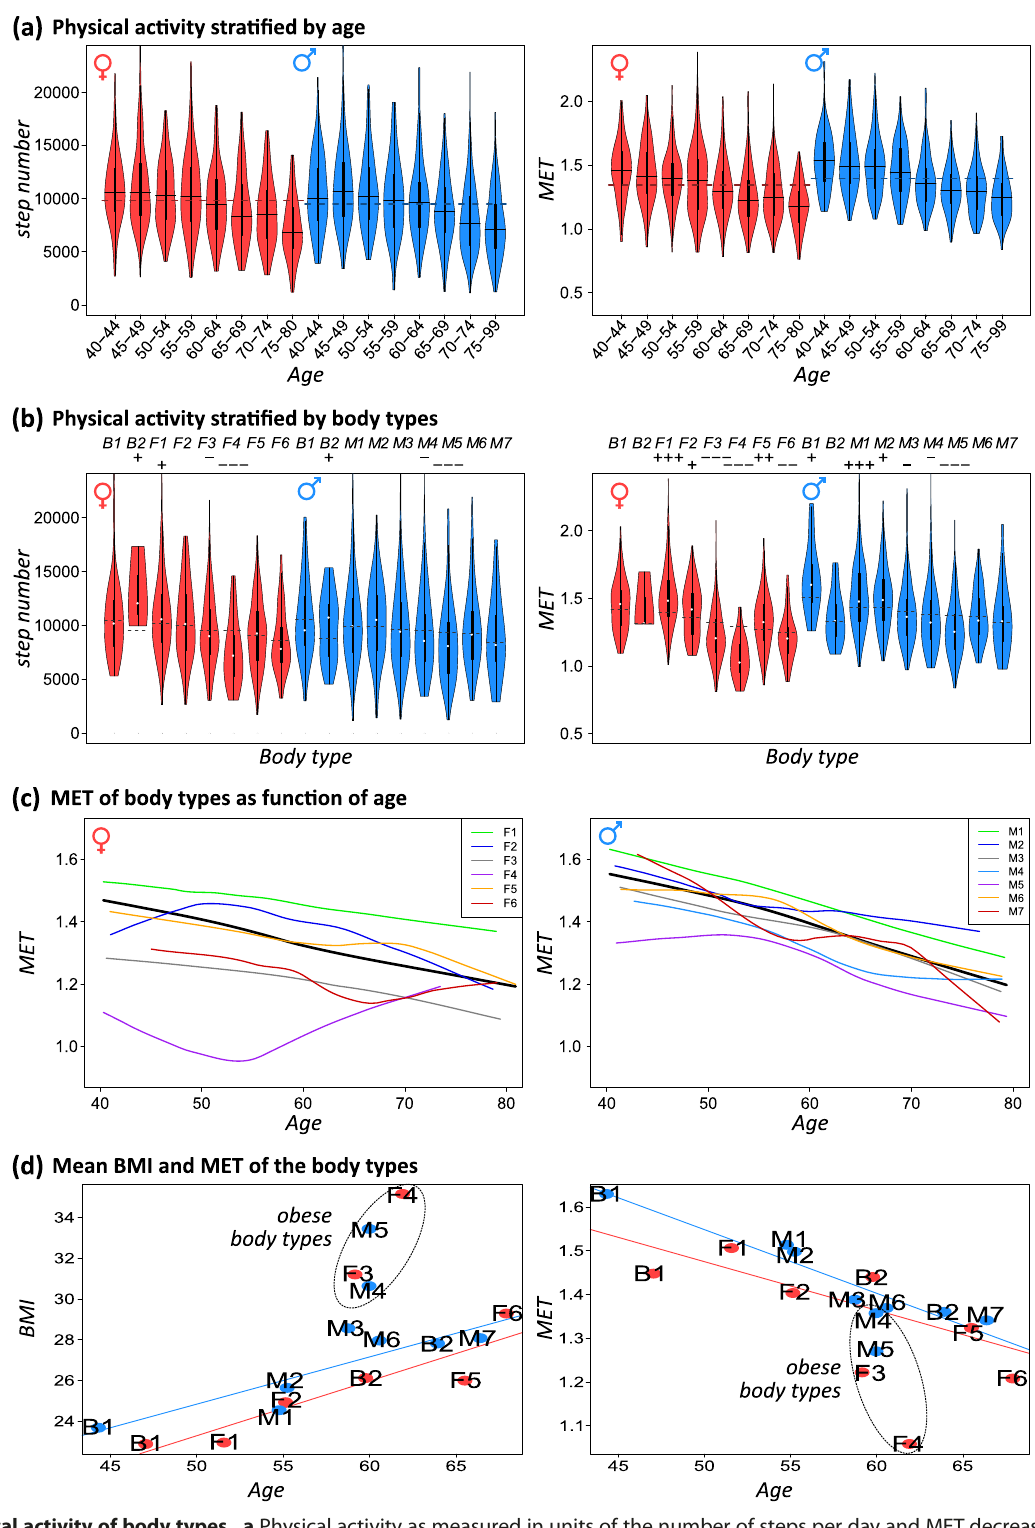
Fig. 7 Physical activity of body types. a Physical activity as measured in units of the number of steps per day and MET decreases with age. b Body types divide into more and less active ones, where the former category collects younger and less obese individuals. Dashed lines indicate median values of the reference age groups, “ + ” and “ − ” symbols in the head line indicate signi fi cant differences between the body types and their reference groups with p values of <0.1 ( + / − ), <0.01 ( ++ / – ) and <0.001 ( +++ / −−− ), respectively. c MET of the body types as a function of age resemble the respective BMI curves in Fig. 6 and re fl ects that high BMI associates with low physical activity. d The plot of body types ’ mean BMI as a function of their mean age can be roughly described by lines of similar positive slopes for women and men ( ≈ 0.25 kg/m 2 per year) if one excludes the obese types F3, F4, M5, and M4. MET provides negative slopes with larger variability of the values of the F-types and F4 as outlier showing lowest MET